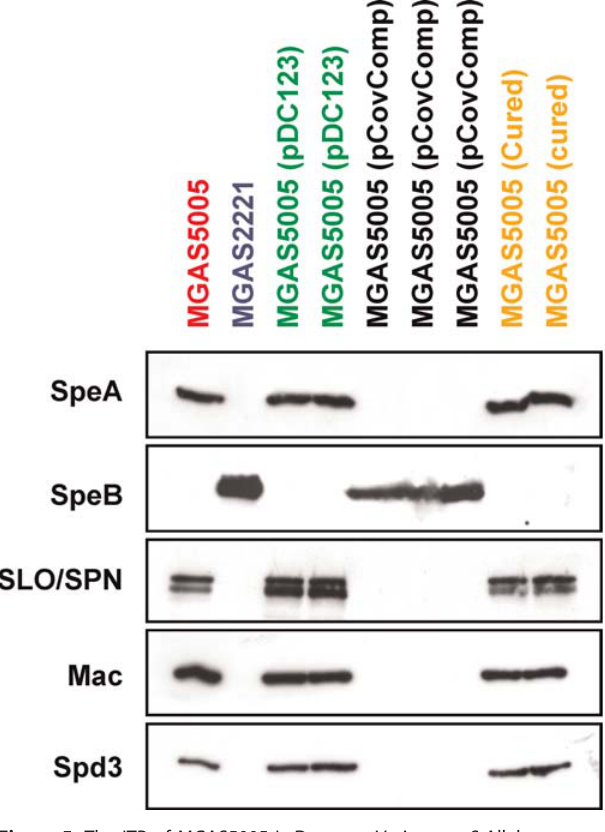
Figure 5. The ITP of MGAS5005 Is Due to a Variant covS Allele Strain MGAS5005 was transformed with a derivative of plasmid pDC123 encoding a functional covS allele (pCovComp), and the supernatants from overnight cultures were analyzed by Western immunoblot for SpeA, SpeB, SLO/SPN, Mac, and Spd3 reactivity. Strain MGAS5005 transformed with vector pDC123 retained the pattern of protein secretion identified for MGAS5005 alone. In contrast, strain MGAS5005 transformed with pCovComp had an altered exoprotein secretion pattern, which was identical to that observed for PTP GAS (e.g., strain MGAS2221). Curing plasmid pCovComp from complemented MGAS5005 returned the secretion pattern to an ITP form.